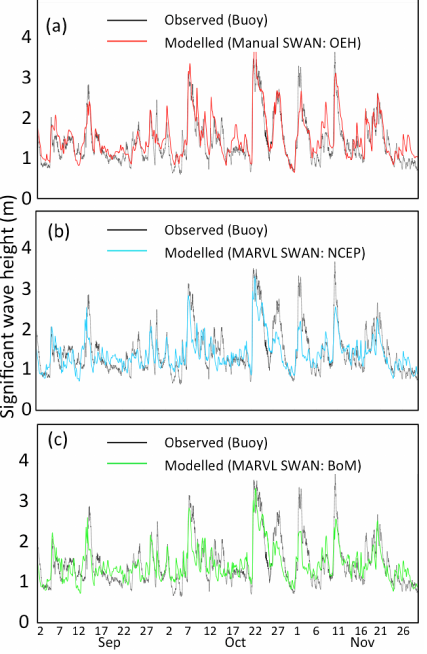
Figure 10. Time series of modelled (colour) and observed (black) significant wave height off Coffs Harbour ( ∼ 12km offshore, in 72m of water), for three different model configurations – Man- ual SWAN: OEH (red, a ); MARVL SWAN: NCEP (blue, b ); and MARVL SWAN: BoM (green, c